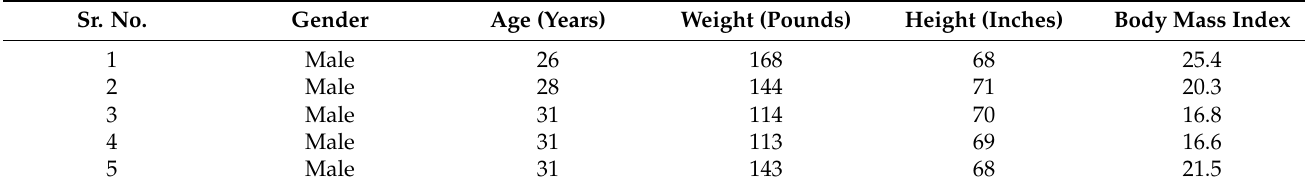
Table 3. Details of volunteers.